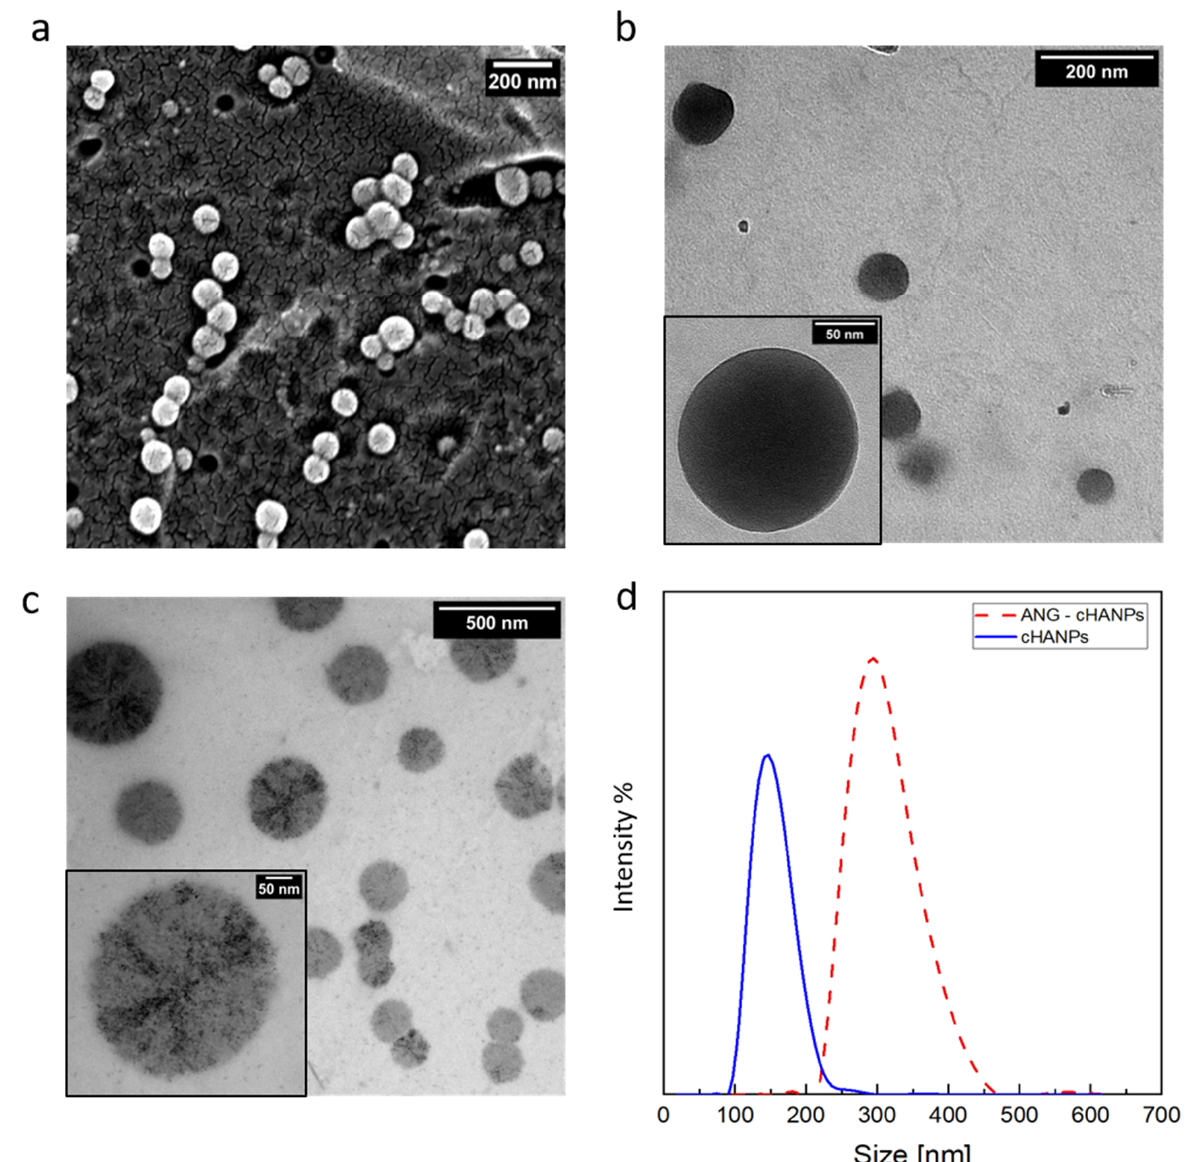
Figure 2. Morphological characterization of crosslinked hyaluronic acid nanoparticles (cHANPs) and angiopep-2 decorated crosslinked hyaluronic acid nanoparticles (ANG-cHANPs). ( a ) SEM images of cHANPs; ( b ) TEM image of cHANPs; ( c ) TEM images of ANG-cHANPs; ( d ) Size distributions of cHANPs and ANG-cHANPs by DLS measurements.